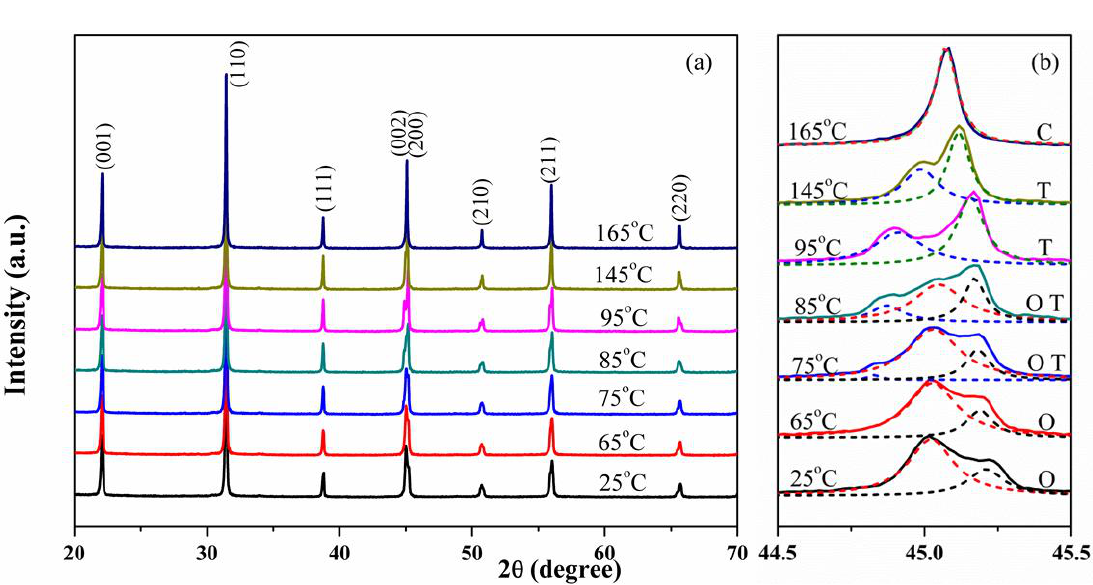
Figure 2. ( a ) Temperature-dependent XRD patterns; ( b ) The {200} around 2θ = 45°. The fitted red and blank dash lines in 25 °C, 65 °C, 75 °C and 85 °C respectively indicate the O phase splitting peaks. The blue dash dot lines in 75 °C, 85 °C, 95 °C, and 145 °C represent the (002) And the pink line in 165 °C is the (200)